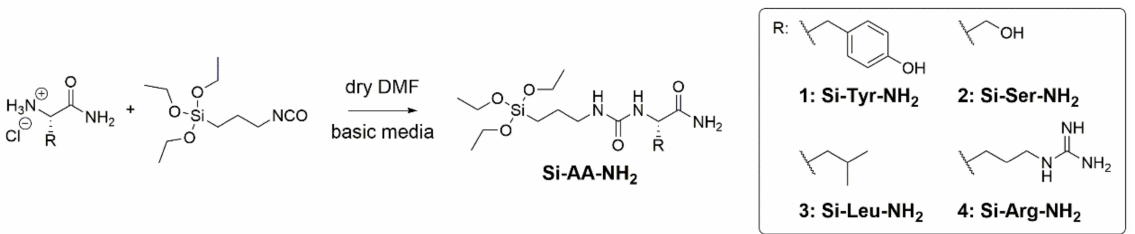
Figure 1. General way of amino amides silylation with ICPTES.